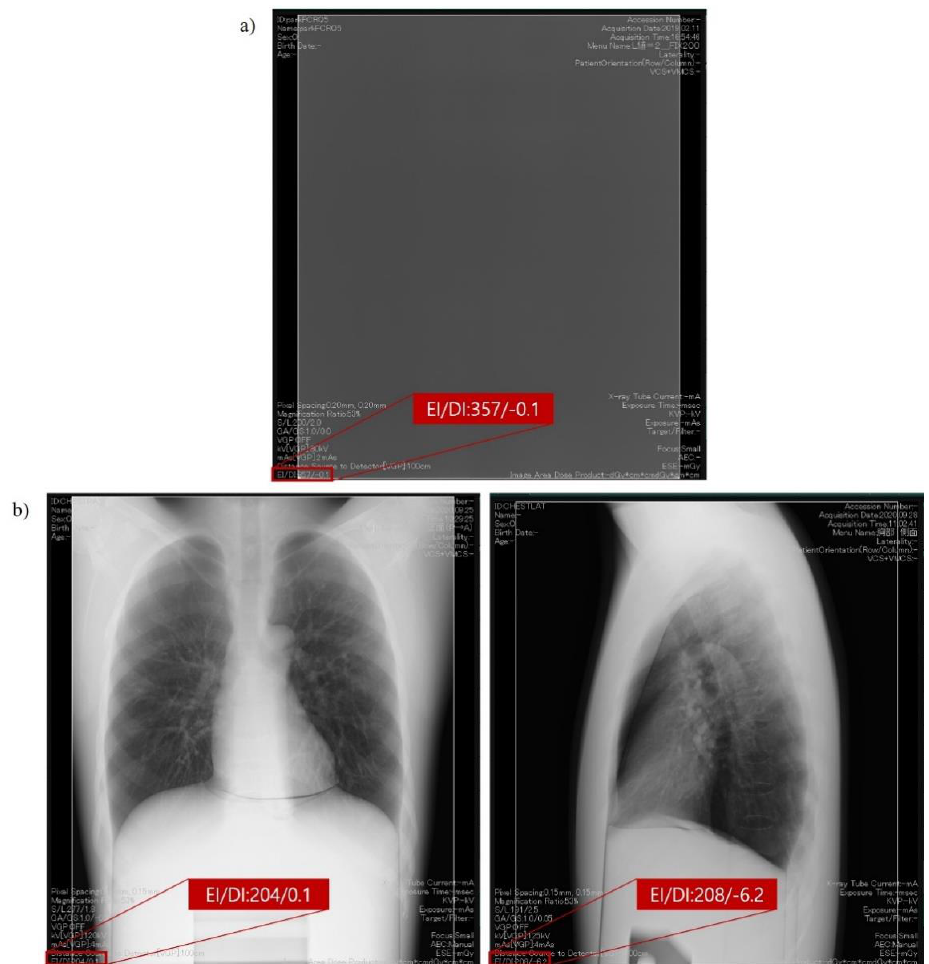
Figure 1. EI and DI* displayed on the digital system console: ( a ) EI as per IEC standards; ( b ) clinical EI of chest PA and LAT examination (*EI T is not calibrated at this time, thus DI is arbitrary value in this figure).